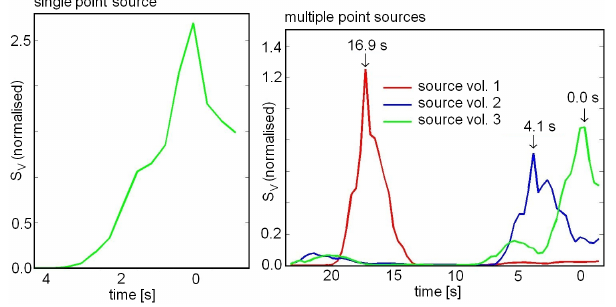
(cid:15) 2 xy d 3 x V